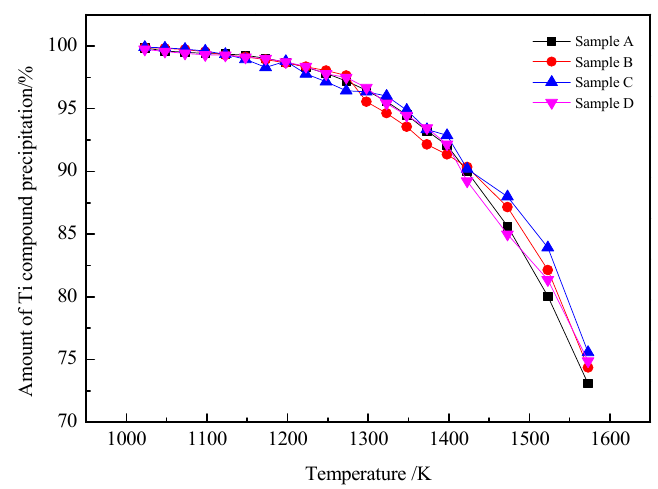
Figure 10. The relationship between the precipitation amount of Ti and temperature .